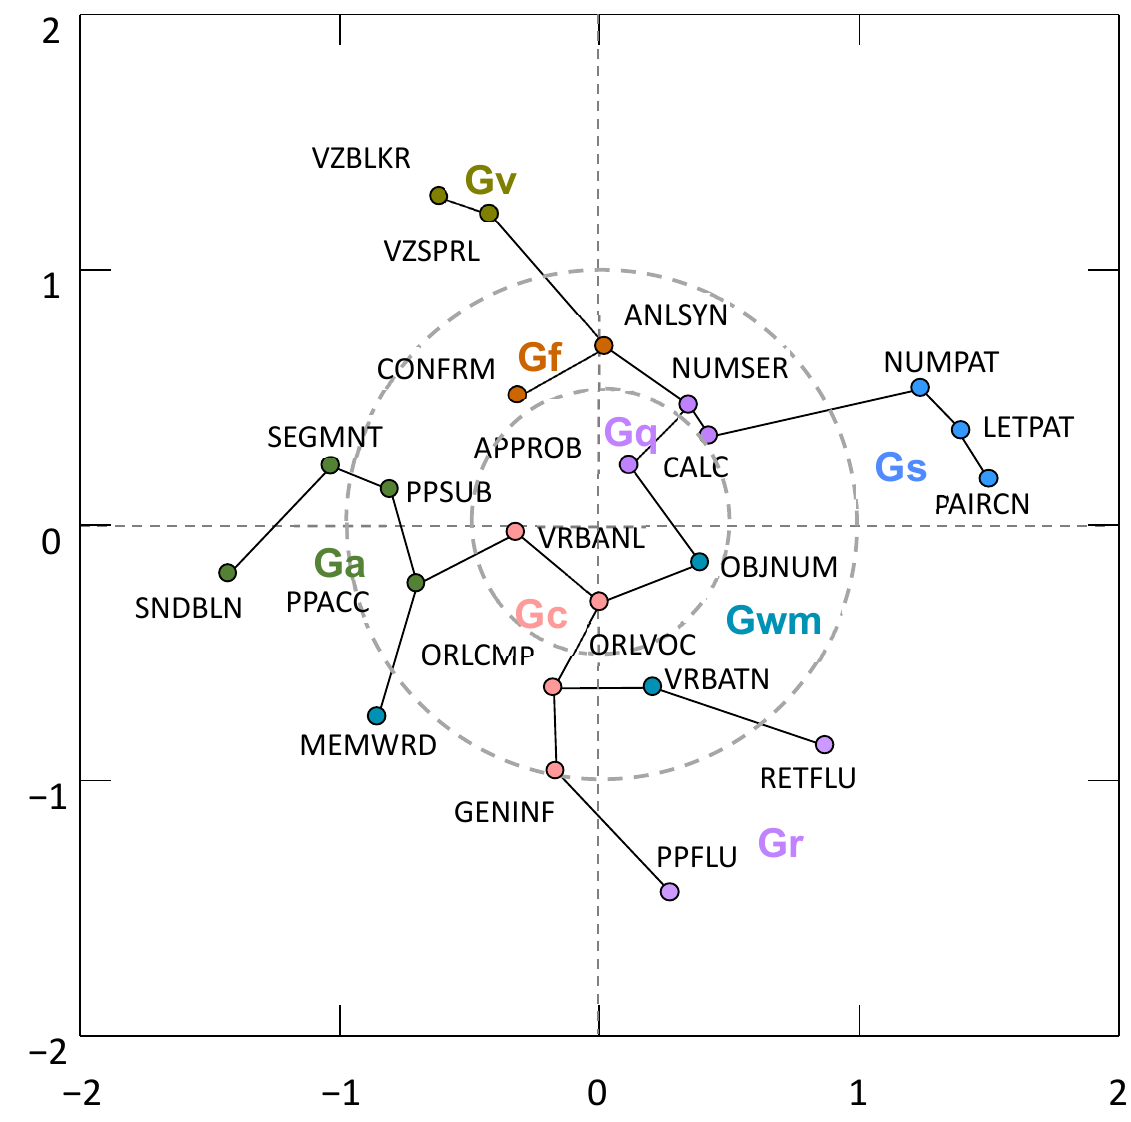
Figure 4. 2-D MDS analysis (Guttman Radex) of a 23-measure secondary sensitivity model connected Figure 4. 2 ‐ D MDS analysis (Guttman Radex) of a 23 ‐ measure secondary sensitivity model by the MST connected by the MST algorithm.